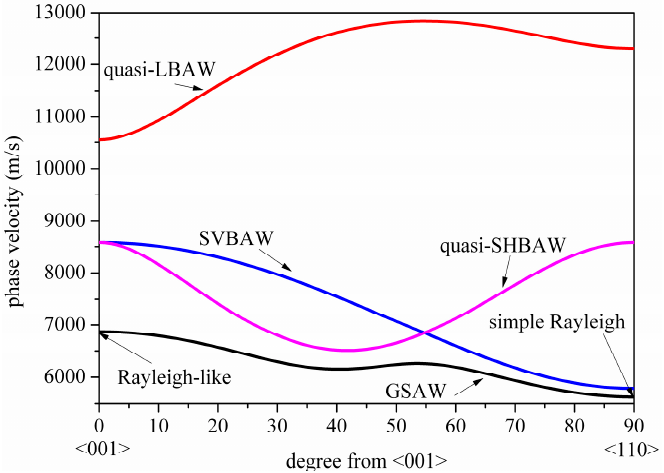
Figure 9. The phase velocity angular dispersion curves of the BAWs and SAWs propagating in the (110) plane of 3C-SiC.